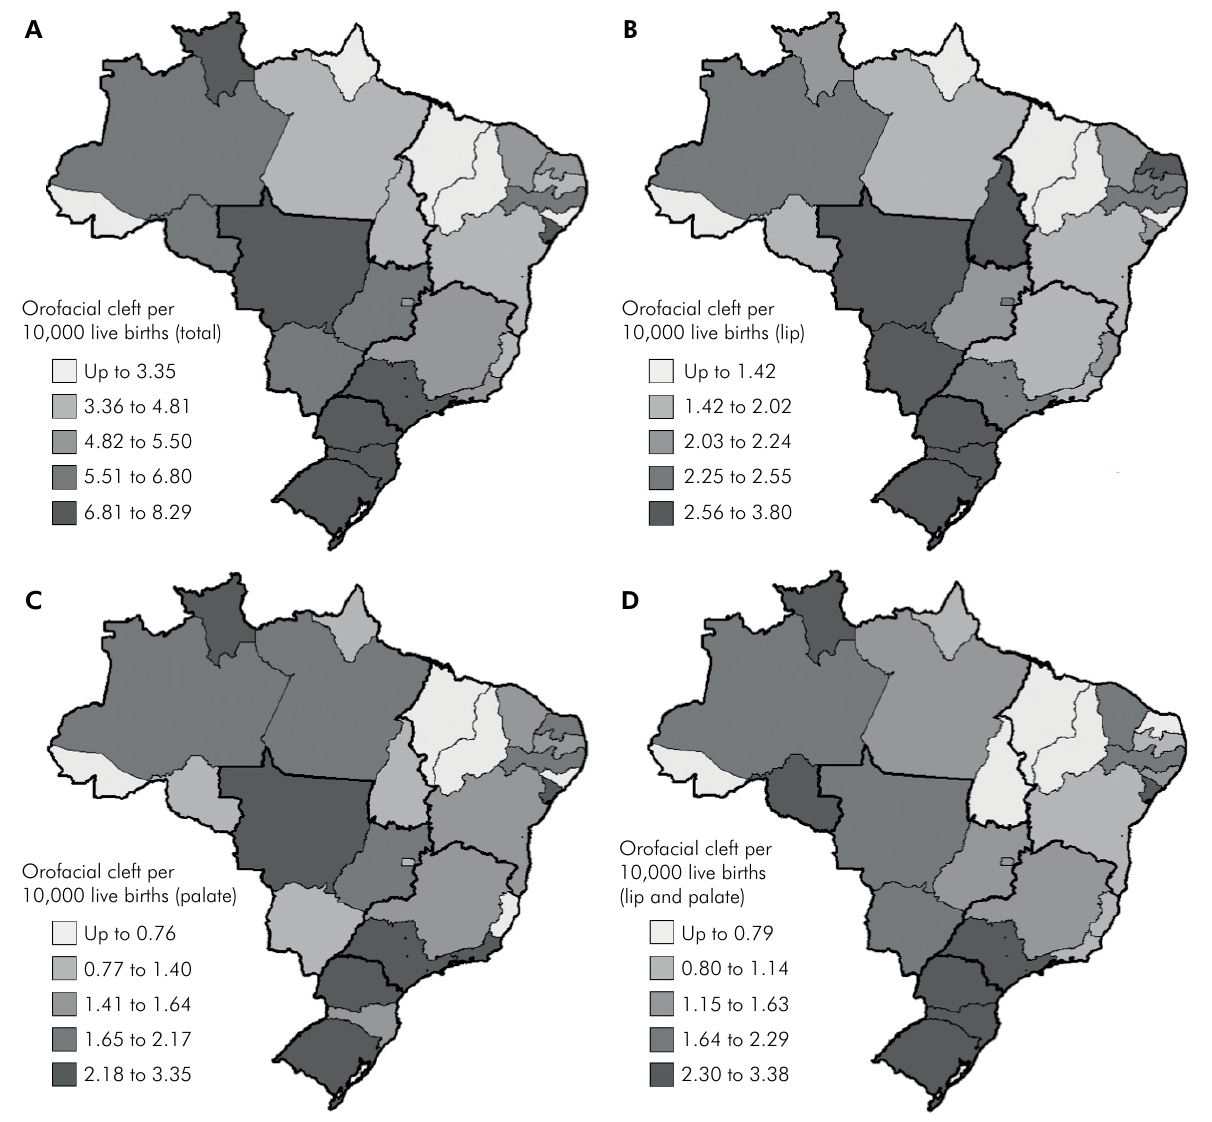
Figure 3. Spatial distribution of orofacial cleft prevalence per 10,000 live births in Brazil from 2009 to 2013.